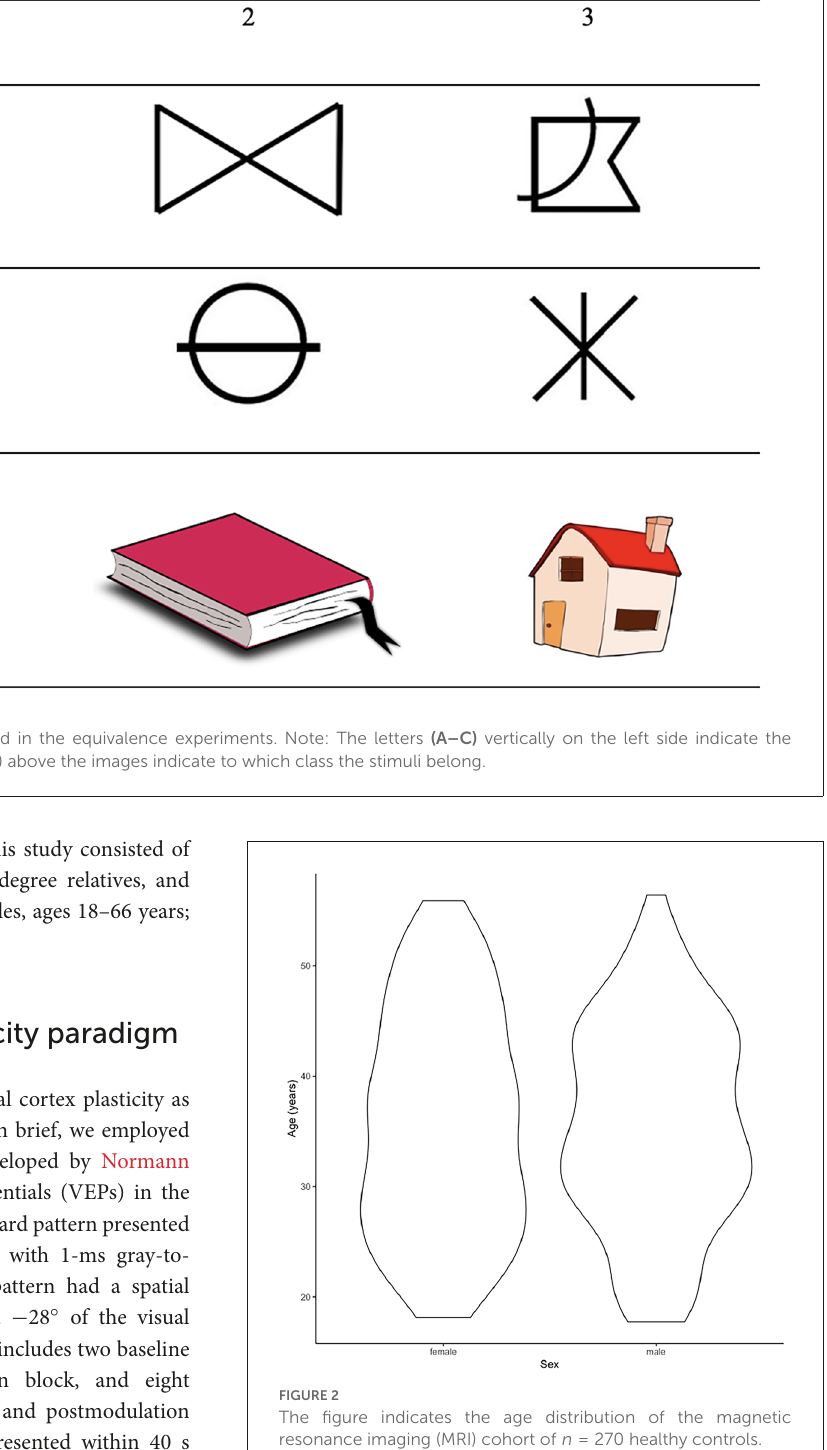
at 120 s, 220 s, 380 s, 480 s, ∼ 30 min, ∼ 32 min, ∼ 54 min, and ∼ 56 min after the end of the modulation block. LTP-like visual cortex plasticity was computed by subtracting baseline